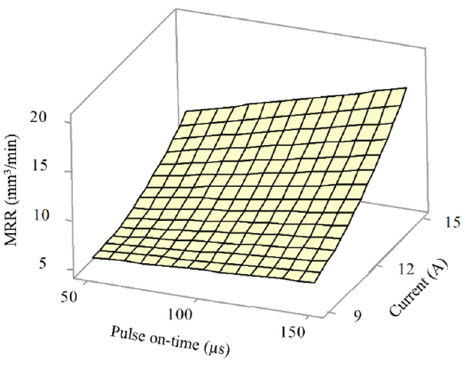
Figure 4. MRR sf as a function of pulse on-time and current, given pulse off-time = 10 µs and electrode rotation = 35 rpm.